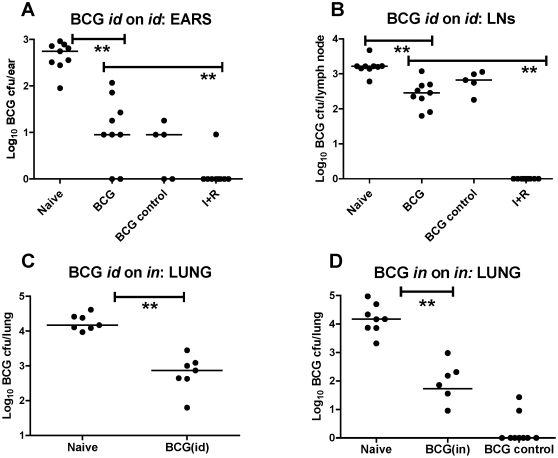
Effect of BCG on a 4-week id and in BCG challenge.BALB/c mice were immunized id with 2.5×103 CFU BCG. Naïve and antibiotic-treated (I+R) mice received no immunization. Four weeks later all mice were challenged either id or in with 4×103 CFU BCG, except the BCG control group who received no challenge. Immediately post-challenge the I+R group was treated for 4 weeks with isoniazid and rifampicin. Ears (a), LNs (b) and lungs (c) were harvested 4 weeks after challenge (spleen cfu data not shown). (d) shows the effect of in BCG on in challenge in a separate experiment. Here, BALB/c mice were immunized in with 1×103 CFU BCG. Naïve mice received no immunization. 4 weeks later in-immunized and naïve mice were challenged with 4×104 CFU BCG in. The “BCG in control” group received no challenge. Lungs were harvested 4 weeks after BCG challenge in all groups. CFU from plating of fresh tissues are shown. Log10 BCG CFU individual data points for each mouse are shown. Bars represent the median per group. (a) Ears (**P<0.01, n = 10); (b) LNs (**P<0.01, n = 10); (c) Lungs (**P<0.01, n = 10); (d) Lungs P<0.01, n = 8 naïve; n = 6 BCG in; n = 8 BCG in control).